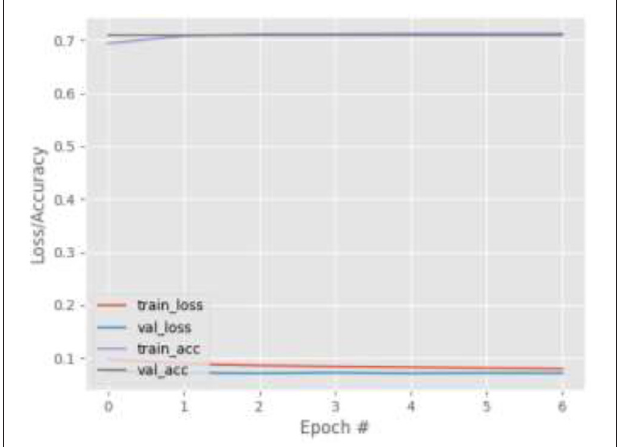
FIGURE 11 | Results for FL only (39-points facial landmarks) on TabletGaze